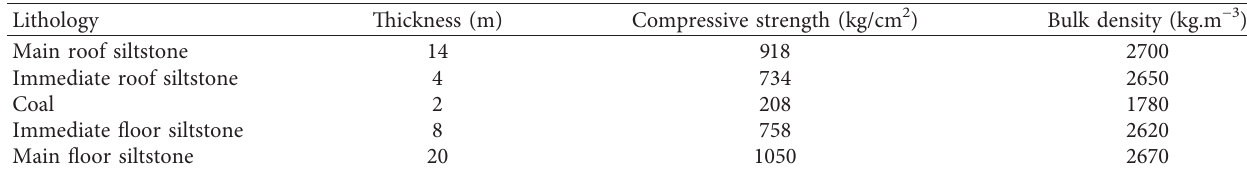
Figure 18: Surrounding rock failure pattern with 200m stope height. (a) Caving. (b) Backfilling. Table 2: The strata physical and mechanical